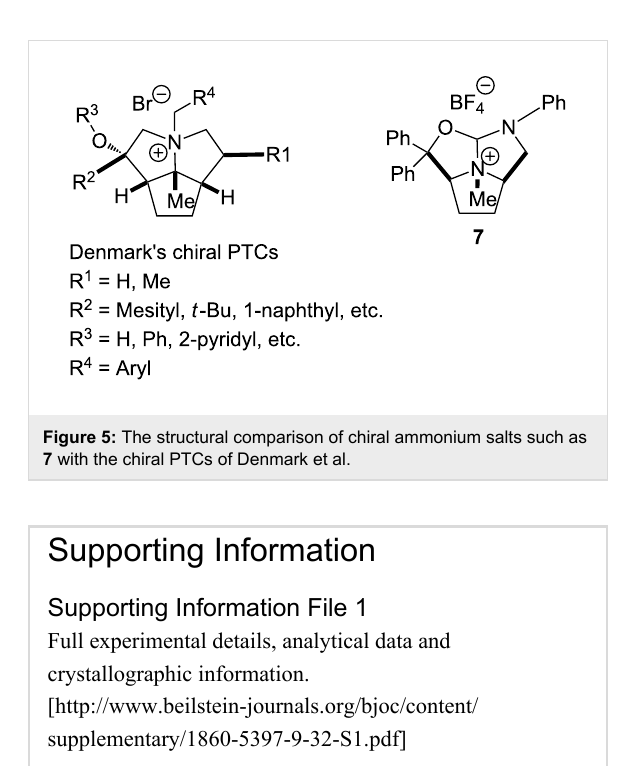
Supporting Information Supporting Information File